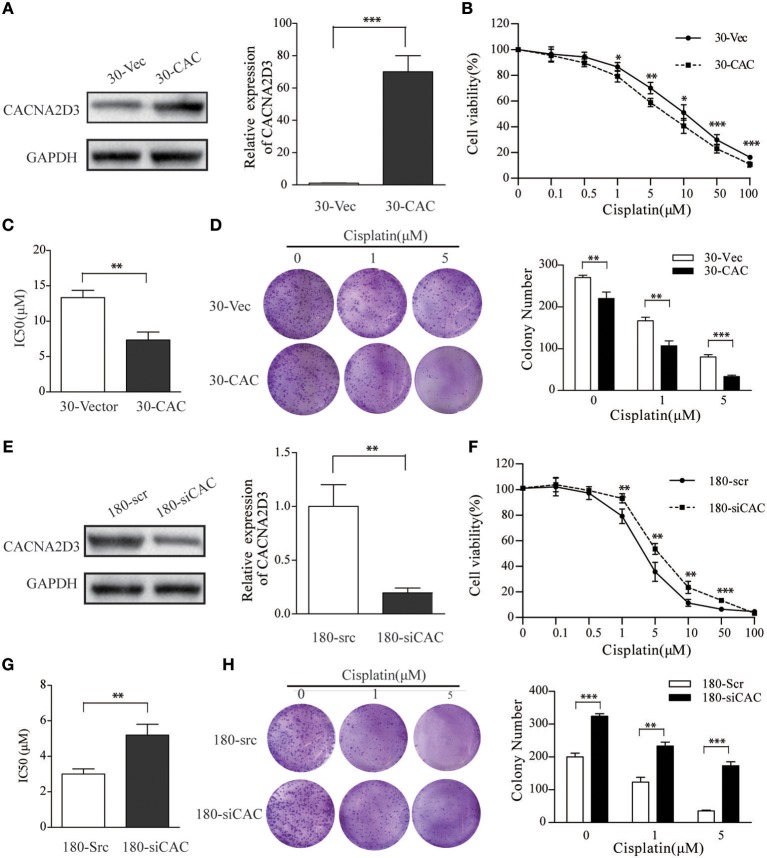
CACNA2D3 promotes chemosensitivity to cisplatin in vitro. (A,E) Stable expression of CACNA2D3 in KYSE30 cells generated by pCDNA3.1-CACNA2D3 transfection and silencing of CACNA2D3 in KYSE180 cells by siRNA were examined by western blotting and qRT-PCR. GAPDH and β-Actin were employed as a loading control. (B,F) CACNA2D3-overexpressing KYSE30 cells and CACNA2D3-knockdown cells were treated with cisplatin at the indicated concentrations for 72 h. The number of viable cells was measured by CCK-8 assay. (C,G) IC50 values were calculated using linear or logarithmic regression (R2 > 0.9). Values are presented as the mean ± SD of three wells. (D,H) Colony forming assays were used to determine colony forming ability after cisplatin treatment. Data are presented as the mean ± SD of three wells. **p < 0.01, ***p < 0.001.